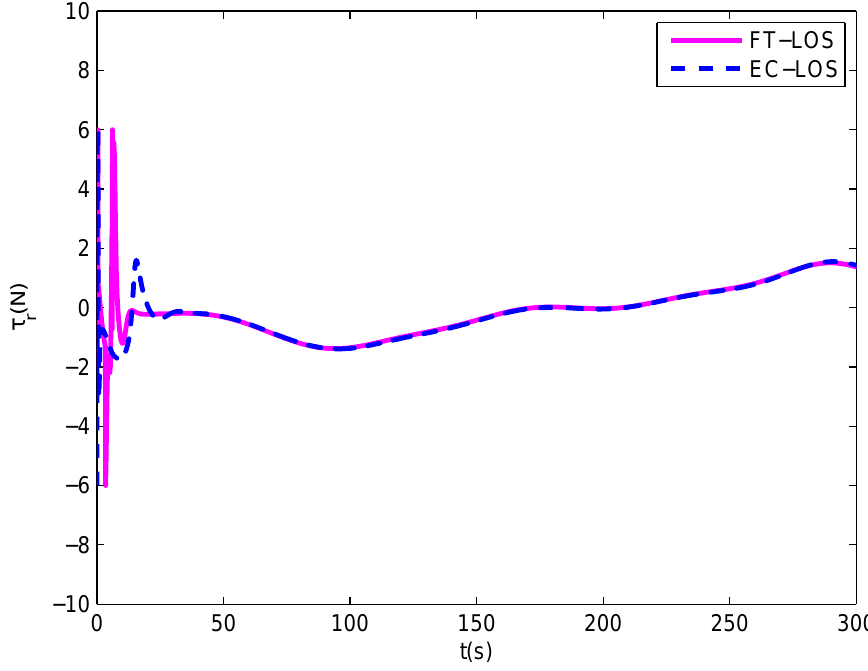
Figure 10. The yaw moment τ r under the input